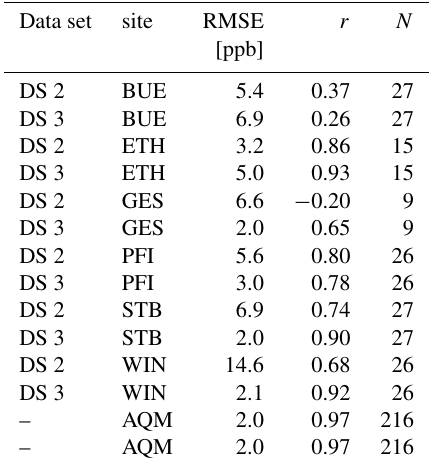
Table 5. Comparison of the NO 2 concentrations provided by the SU with the diffusion tube concentrations for each site of the sensor network. The row denoted by AQM summarises the comparison be- tween measurements from instruments of AQM sites and diffusion tube measurements. Data set refers to the sensor data processing strategy outlined in Table 4. RMSE, r and N denote the root mean square error, the Pearson correlation coefficient and the number of samples,